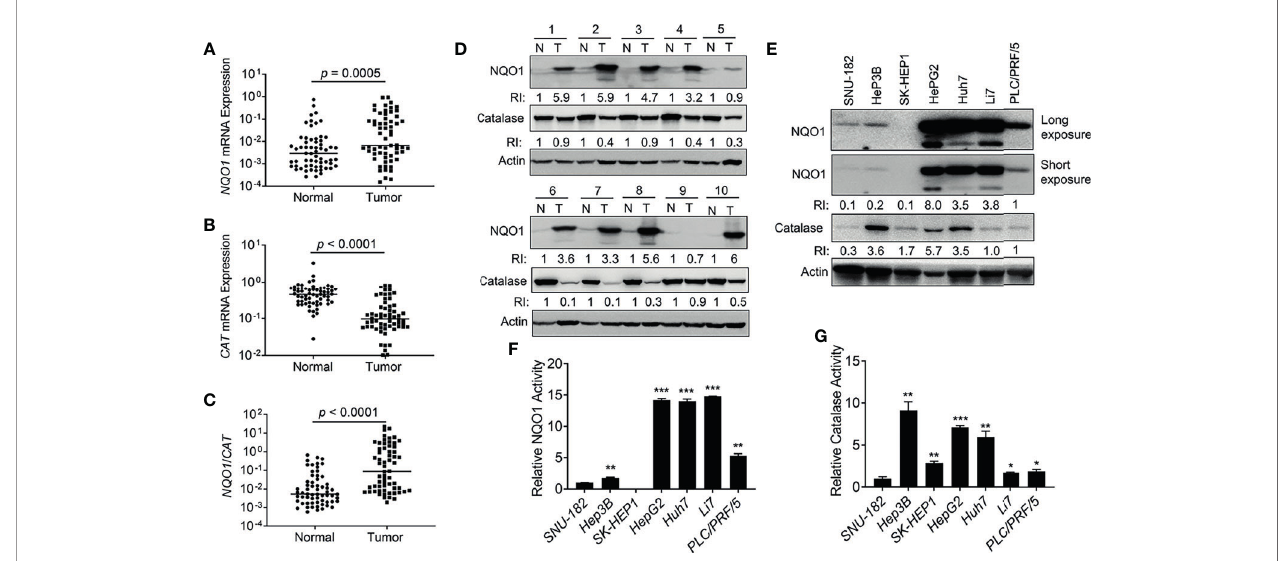
FIGURE 2 | NQO1 and catalase expression in hepatocellular carcinoma patients and cell lines. (A – C) mRNA expression of NQO1 (A) , CAT (B) , and NQO1 / CAT Ratio (C) in 62 pairs of HCC patient tumor samples and associated normal tissues. (D) Representative western blotting analysis of NQO1 and catalase protein expression in HCC patient tumor samples and adjacent normal tissues. N, Normal; T, Tumor; RI, Relative Intensity. Data were measured as relative intensity (RI) of NQO1/Actin, and catalase/Actin. The protein expression in normal tissues was de fi ned as 1. (E) NQO1 and catalase protein expression in HCC cell lines. Data were measured as RI of NQO1/Actin, and catalase/Actin. The protein expression in PLC/PRF/5 (last lane) was de fi ned as 1. (F, G) Relative NQO1 and catalase enzyme activities in various HCC cell lines were detected by the NQO1 and catalase activity assay kit respectively, all error bars are means ± SDs. *** p < 0.001, ** p < 0.01, * p < 0.05 (t